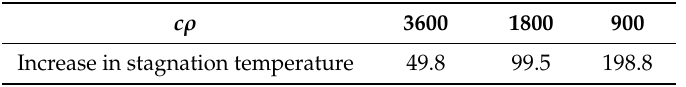
Table 4. Material thermal conductivity and aircraft temperature field 1 .